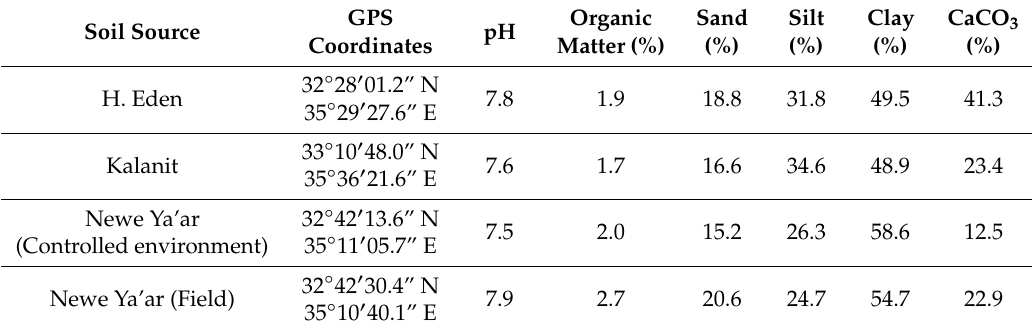
Table 1. Selected properties of the soils used in this